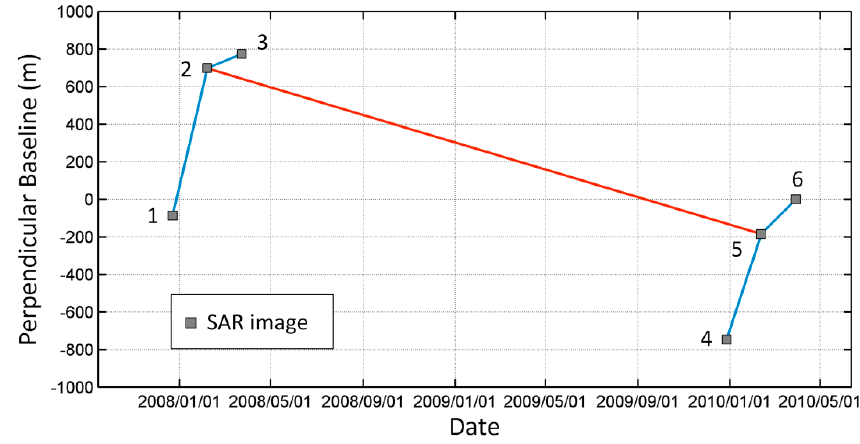
Figure 7. The temporal and spatial baseline distribution of ALOS/PALSAR interferometric pairs. The images connected by the blue line constitute interferometric pairs and the interferograms connected by the red line are co-registered to the same image space.